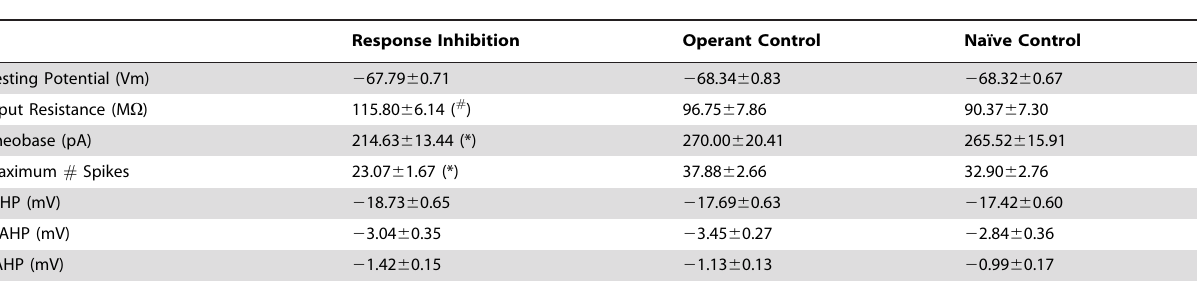
Table 1. Characteristics of prelimbic